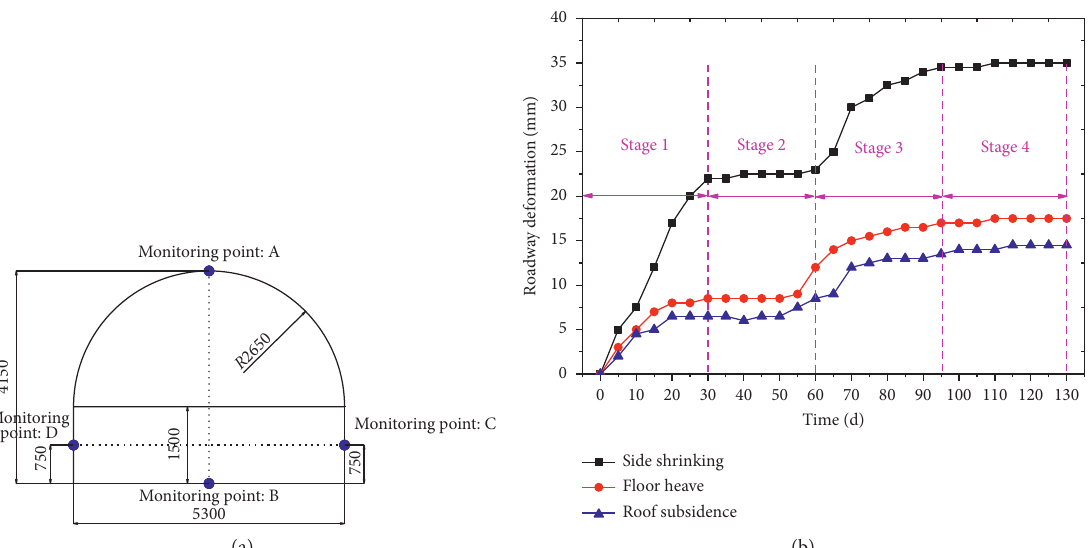
Figure 17: Monitoring curve of surrounding rock deformation of the entrance roadway: (a) distribution of the monitoring points; (b) curves of convergent deformation.